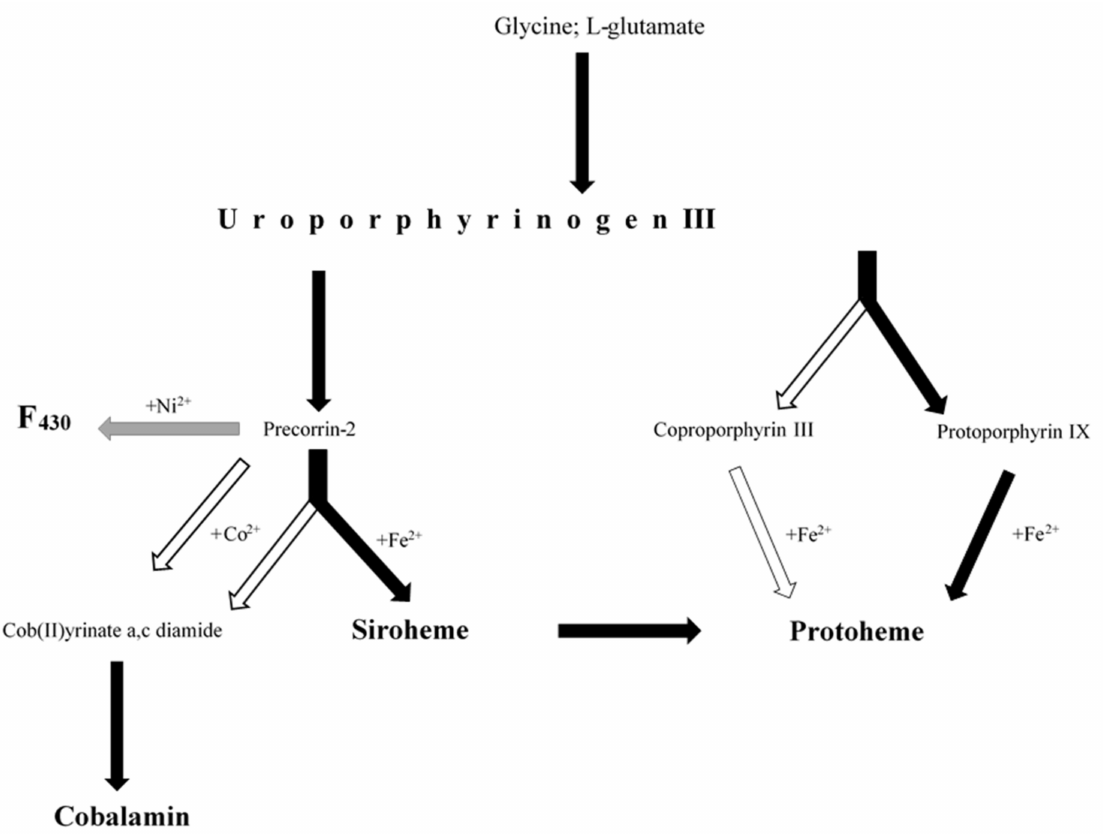
Figure 1. Biosynthetic pathways of tetrapyrrole cofactors (protoheme, siroheme, cobalamin and F 430 ) investigated in this study, including the most important precursors (glycine; L-glutamate, uroporphyrinogen III) and intermediates (coproporphyrin III, protoporphyrin IX, precorrin-2, cob(II)yrinate a,c diamide). A detailed description of the pathways is included in the manuscript and in Supplementary Materials (Table S1 and Figures S1–S8). The colour of the arrows indicates whether the pathways have been fully detected (black), partially detected (white) or undetected